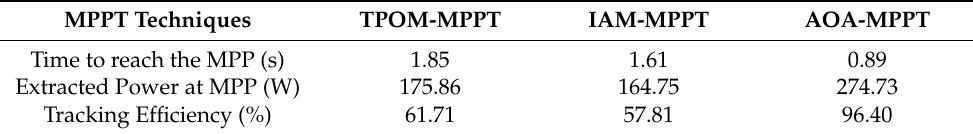
Table 2. A comparative study among TPOM-MPPT, IAM-MPPT, and AOA-MPPT.